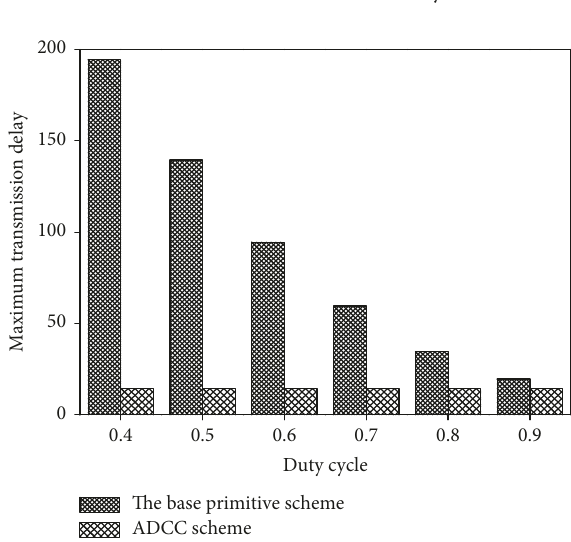
Figure 20: The transmission delay.